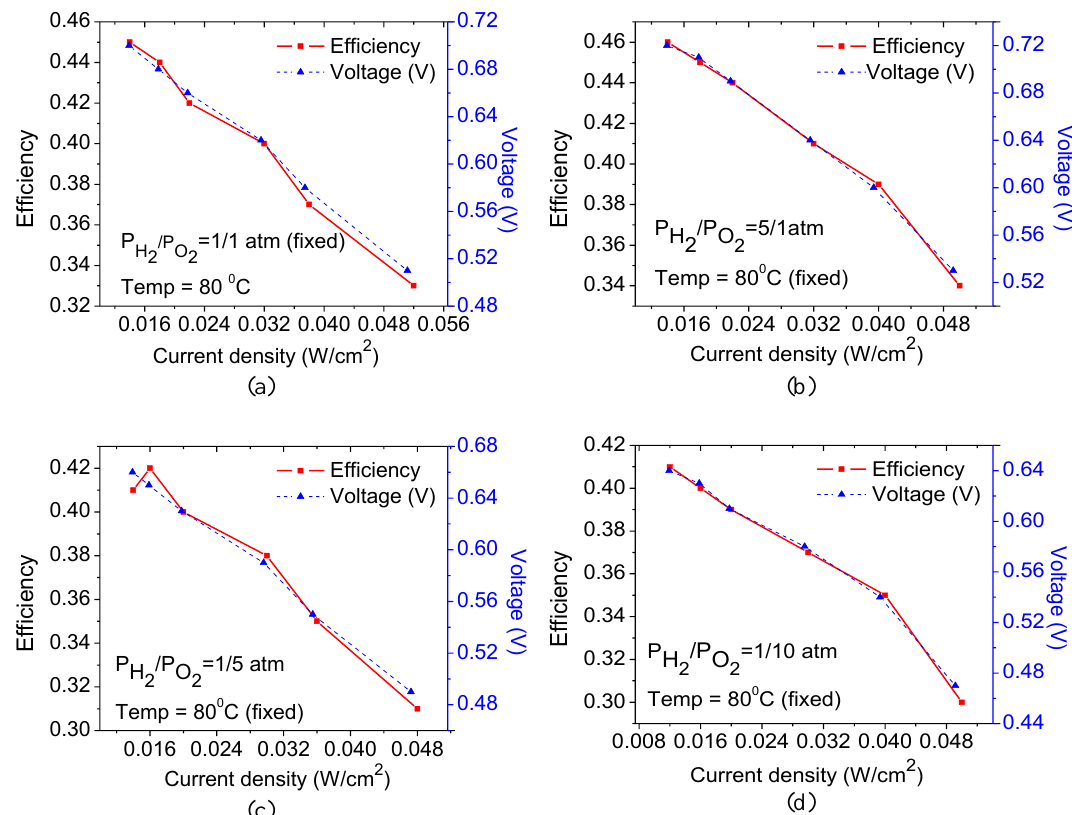
Figure 2. (a)-(d). Efficiency, current density and voltage at fixed temperature and reactant flow